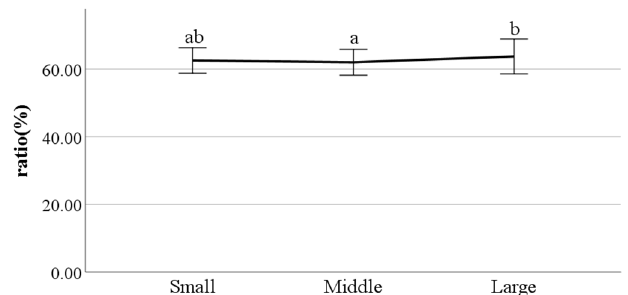
Figure 26. The ratio of stance phase of right foot (F value: 3.12, DF: 2, p -value: 0.04).